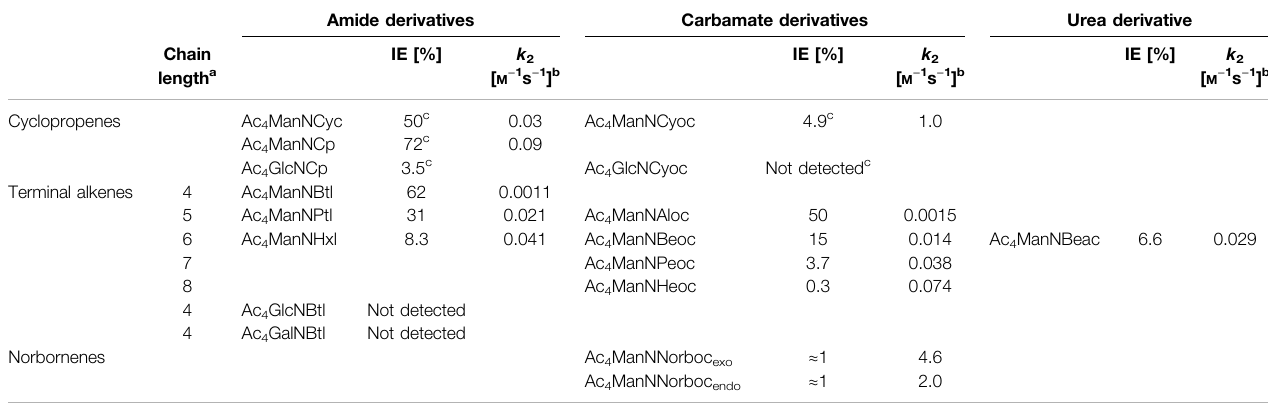
TABLE 1 | Incorporation ef fi ciencies (IE) as sialic acids in MGE experiments and second-order rate constants k 2 of aminosugar derivatives with dienophile reporter groups (Niederwieser et al., 2013; Späte et al., 2014c; Späte et al., 2016; Dold et al., 2017; Hassenrück and Wittmann, 2019; Dold and Wittmann, 2021). Amide